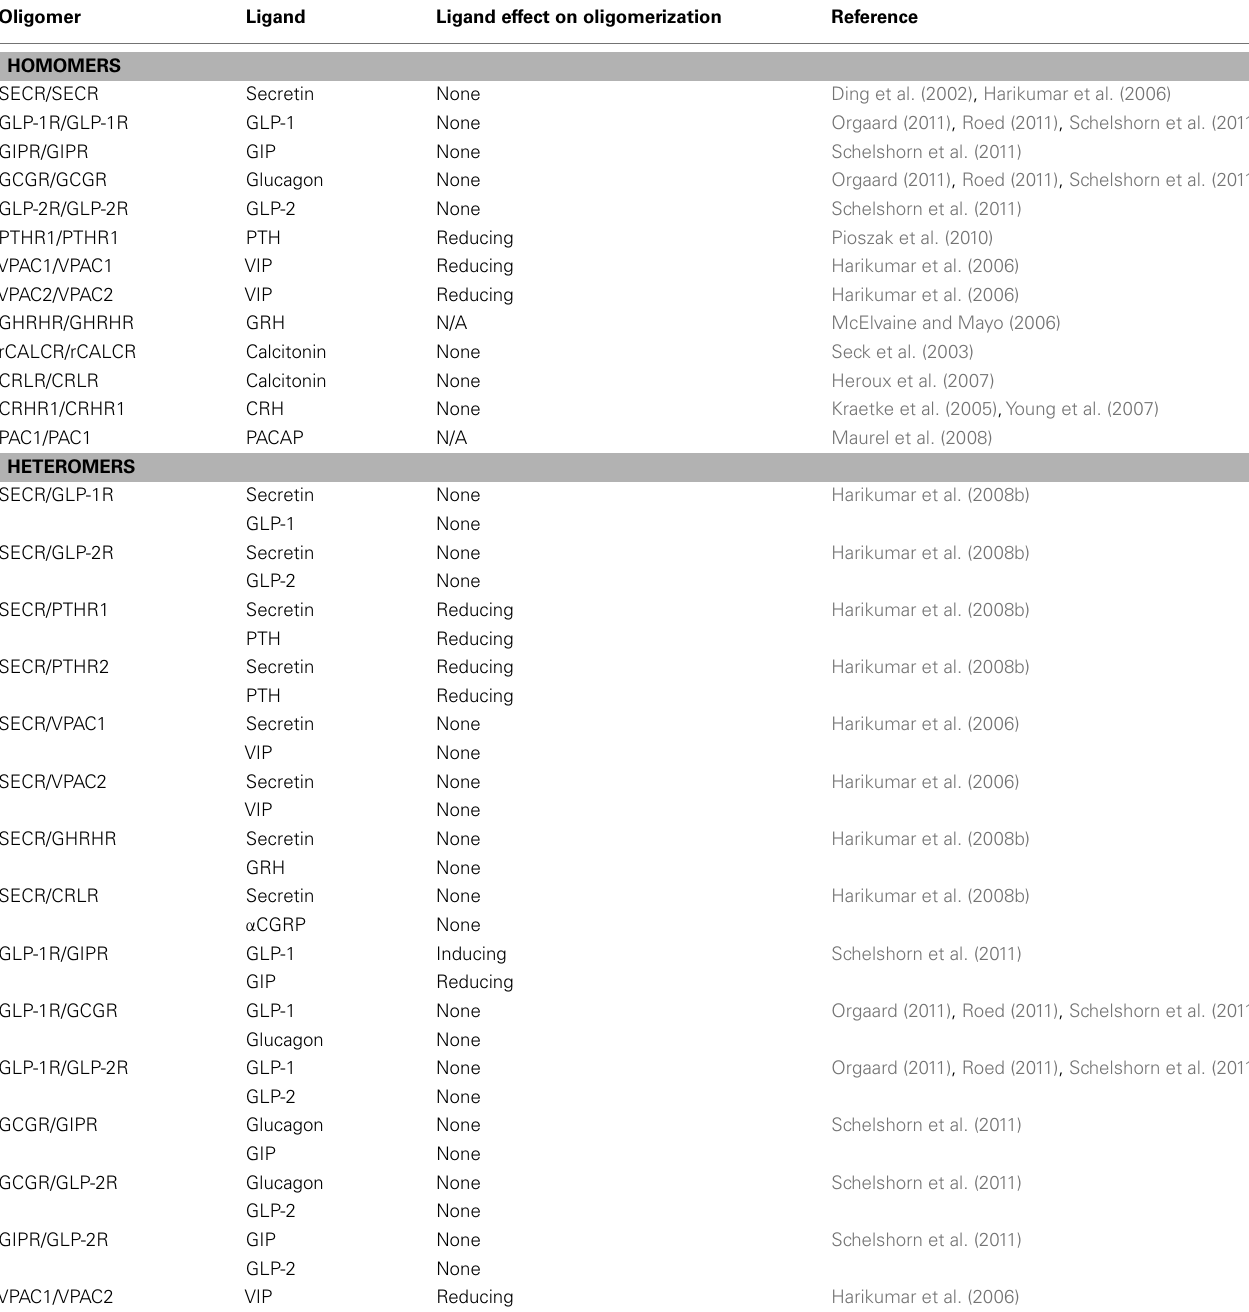
Table 2 | Oligomerization of the family B1 GPCRs and the effect of ligand binding. Oligomer